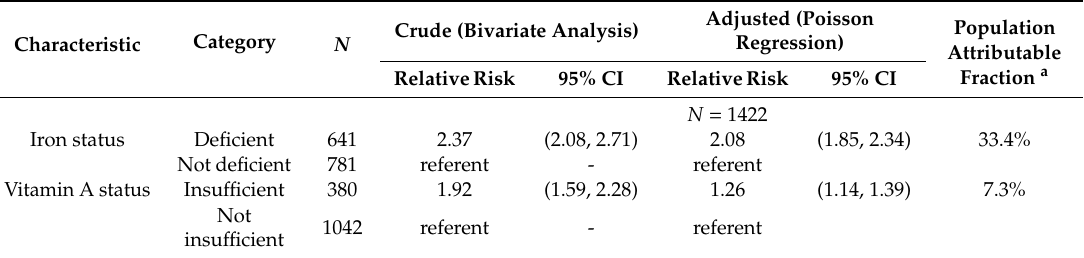
Table 6. Crude and adjusted relative risk of anemia in non-pregnant women, The Gambia